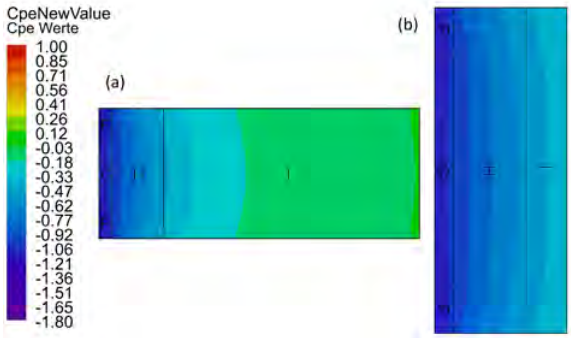
Figure 11. Numerical results of the external pressure coefficients of the roof for (a) flow on the short side and (b) flow on the long side.